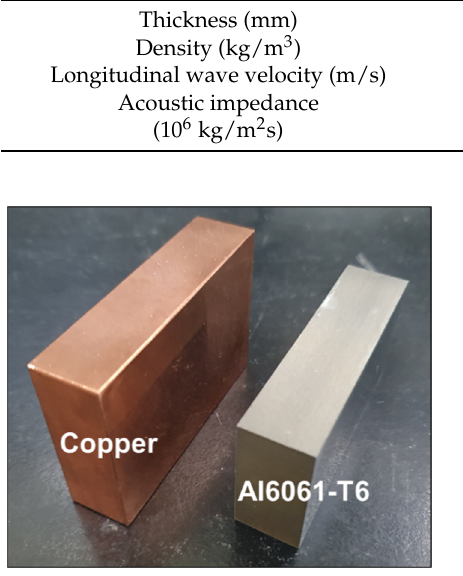
Figure 2. Images of tested specimens.